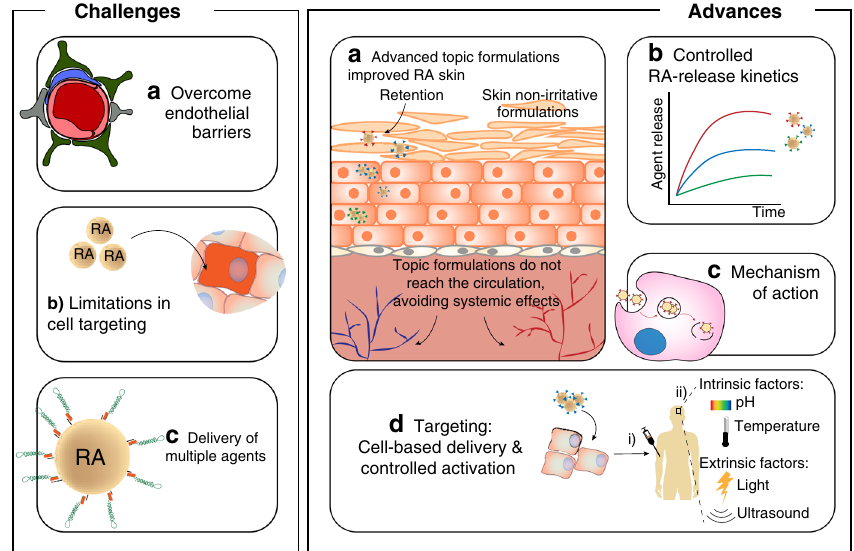
Fig. 4 Challenges and advances in topical and systemic administration of RA-containing formulations. Challenges include: a crossing endothelial barriers for extravasation of RA-containing formulations into a speci fi c body region; b targeting of RA-containing formulations to speci fi c cells; c development of formulations that combine RA with other pharmacological agents, able to release each agent with a speci fi c release kinetics. Advances include: a development of formulations with less toxicity; b release of RA with variable release kinetics to achieve variable biological actions; c action mechanism of RA during development and disease; d use of cells to transport RA-containing formulations to speci fi c regions in the body followed by the triggering of the formulations by intrinsic (e.g., temperature, pH) or extrinsic (e.g., ultrasound, light) stimuli. RA retinoic